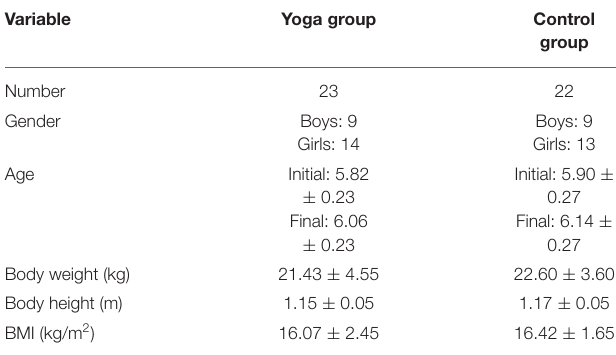
TABLE 1 | Decriptive statistics (Mean ±